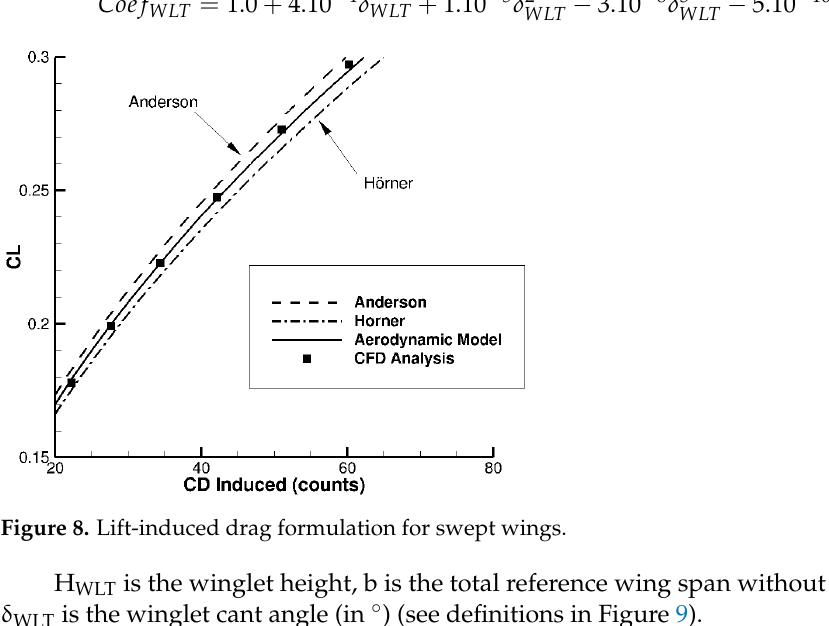
Figure 8. Lift-induced drag formulation for swept wings.